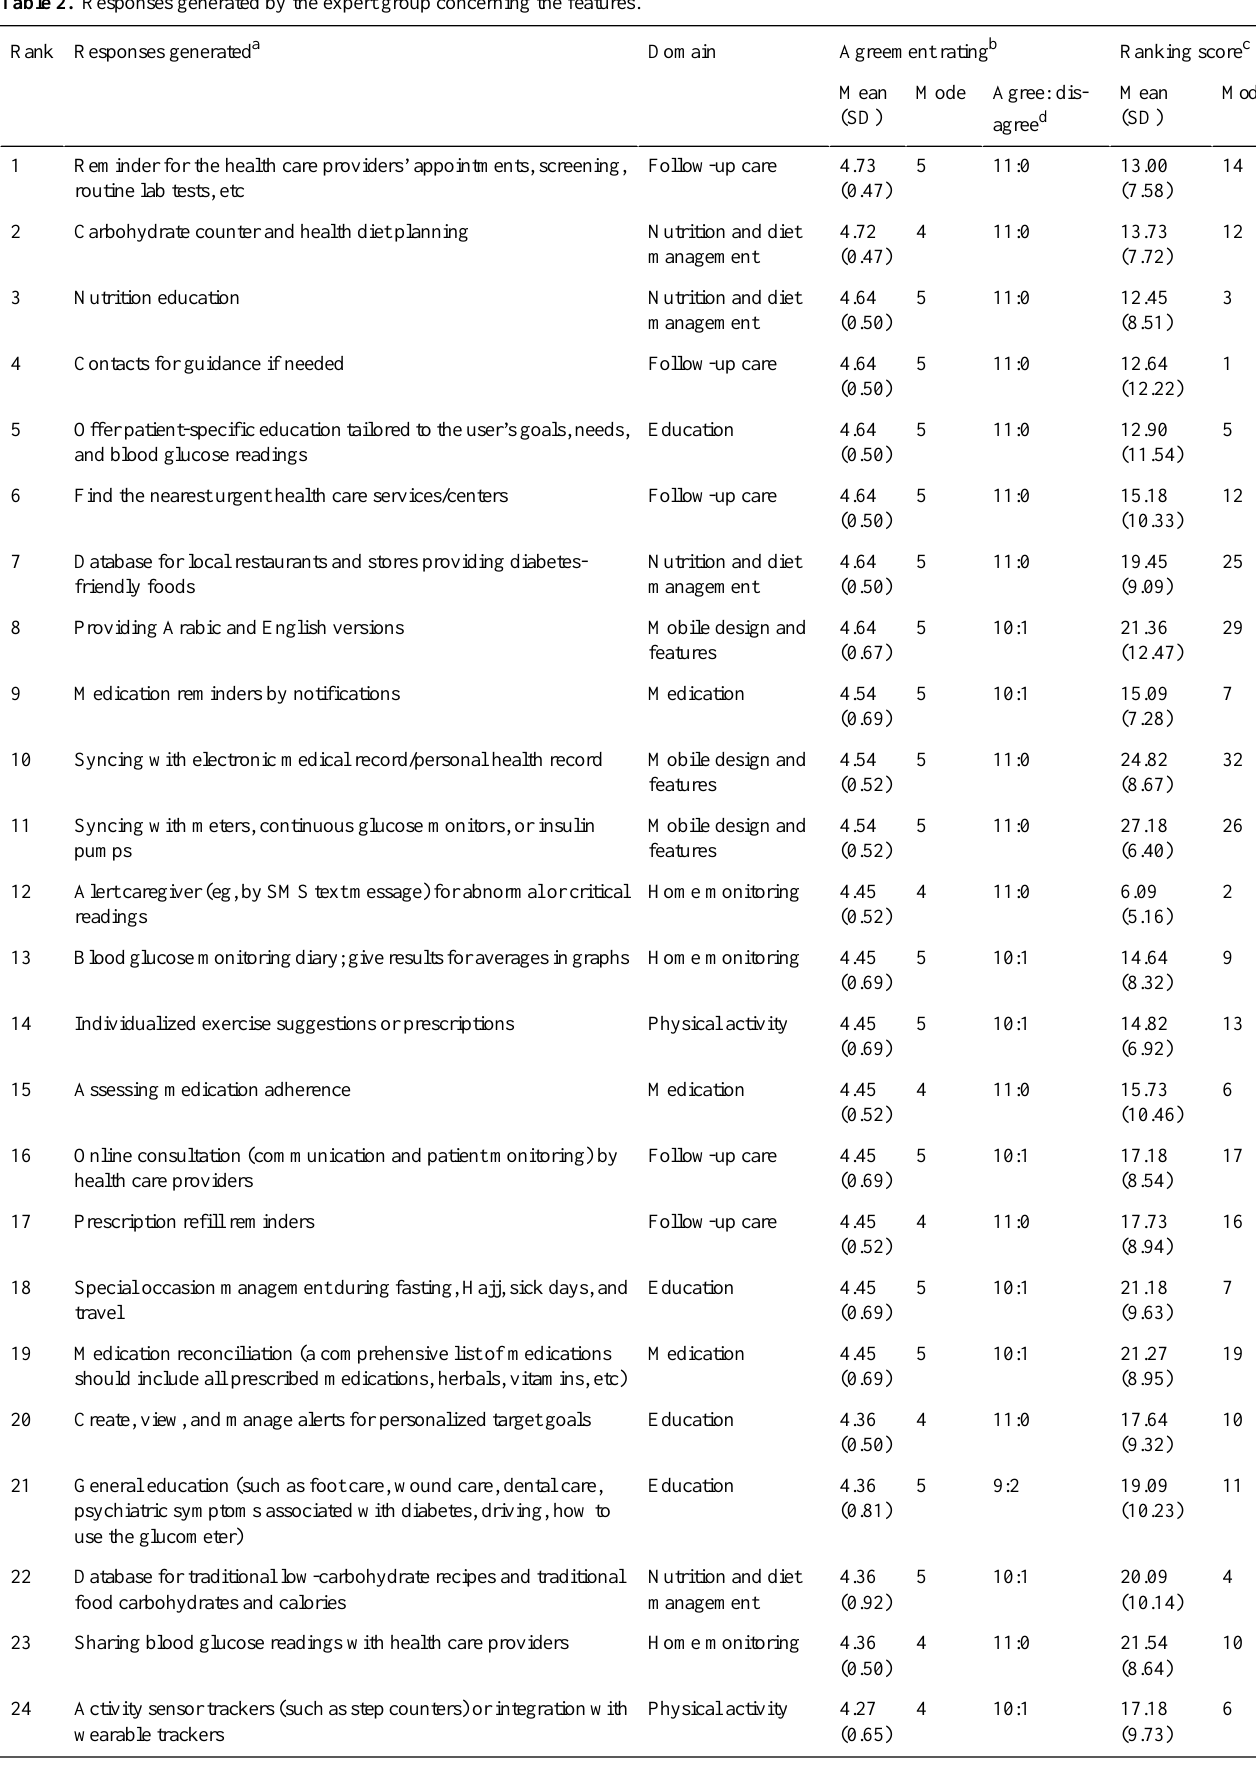
Table 2. Responses generated by the expert group concerning the